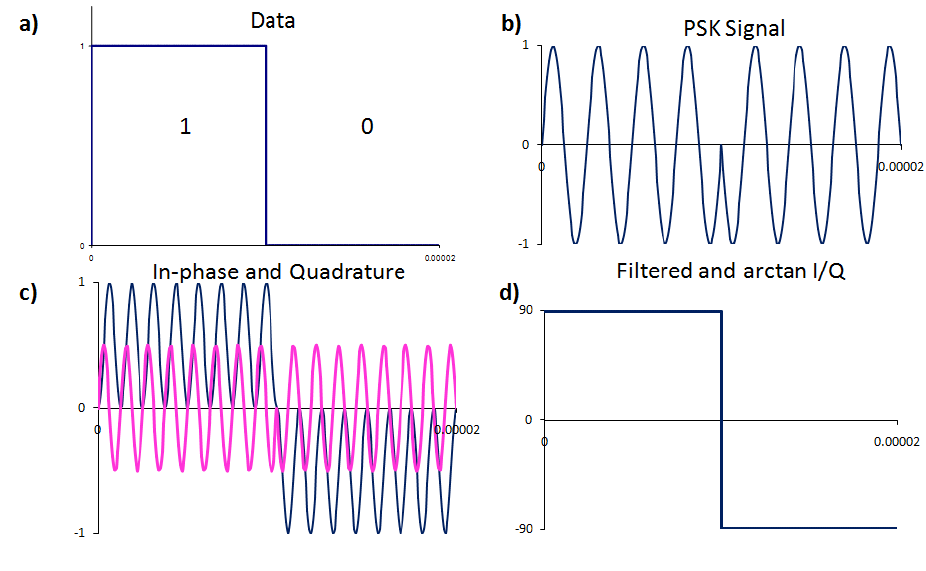
Figure 4. Decoding a phase shift keying signal, (a) the digital data to be transmitted, (b) the phase shift keying signal, (c) the in-phase and quadrature components, (d) digital information recovered after filtering and